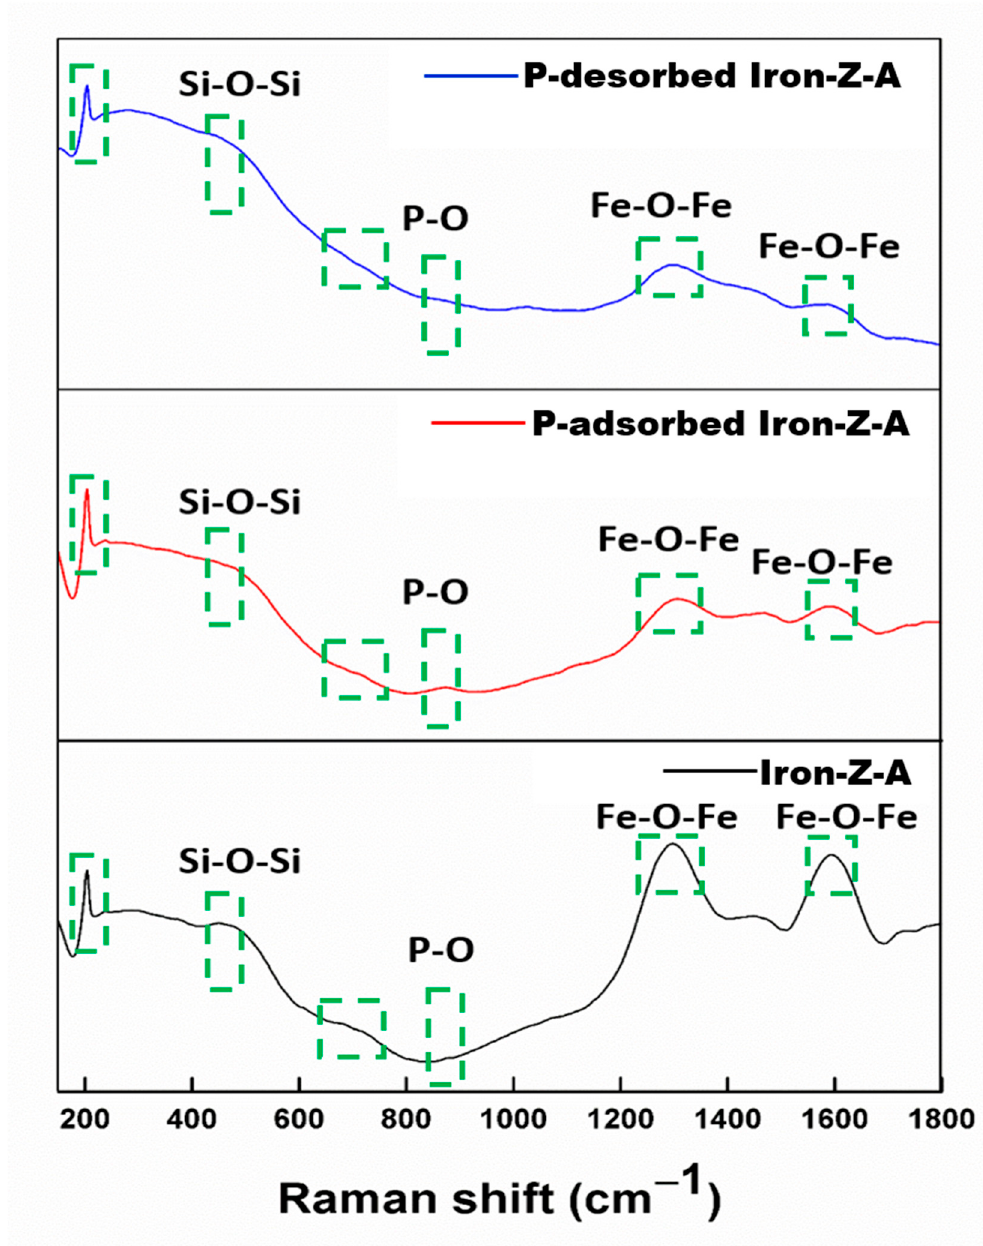
Figure 6. Shifts in peaks of FT-Raman of Iron-Z-A, P-adsorbed Iron-Z-A, and P-desorbed Iron-Z-A.